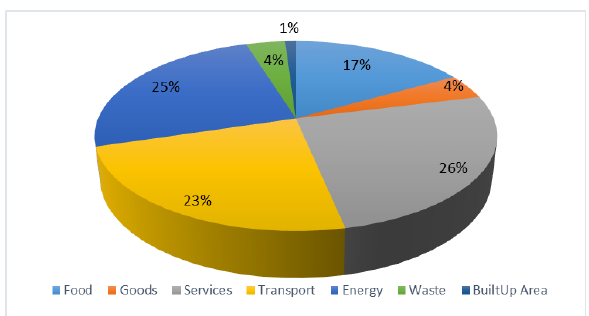
Figure 15. Per Capita Materials Consumption Percentage at the Household Level.